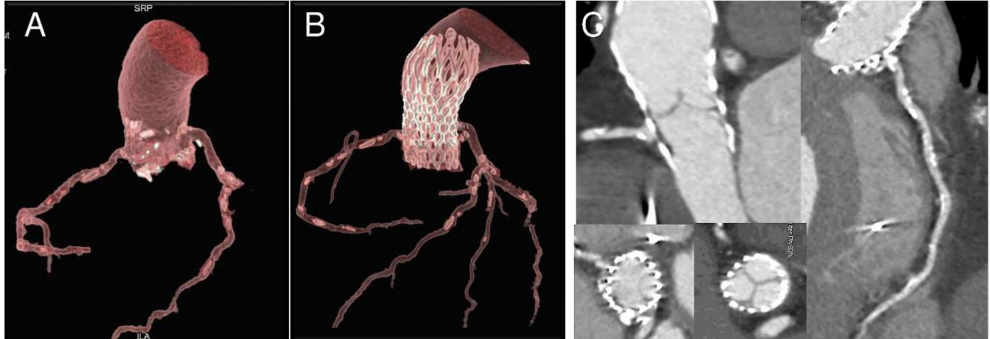
Figure 2. Nine-month follow-up gated CT scan demonstrating bioprosthesis malposition in respect to left main coronary. 3D reconstructions in longitudinal and cross-section before ( A ) and after the procedure ( B , C ). Please note coronary ostia proximity with calcifications and ostial stenosis due to partial obstruction by a portion of the THV frame ( C ).